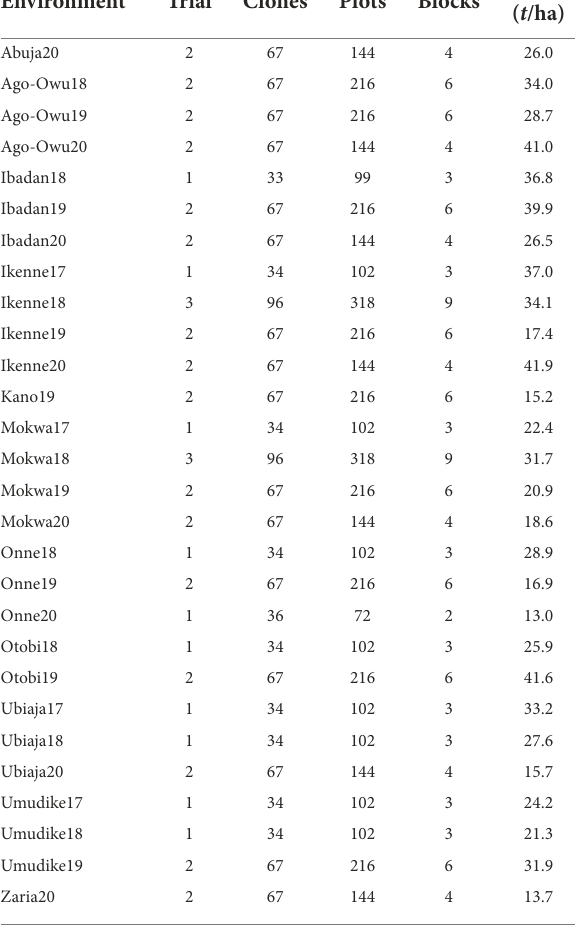
TABLE 1 Summary of number of trials, cassava clones, plots, blocks and mean fresh root yield (FYLD) per environment.